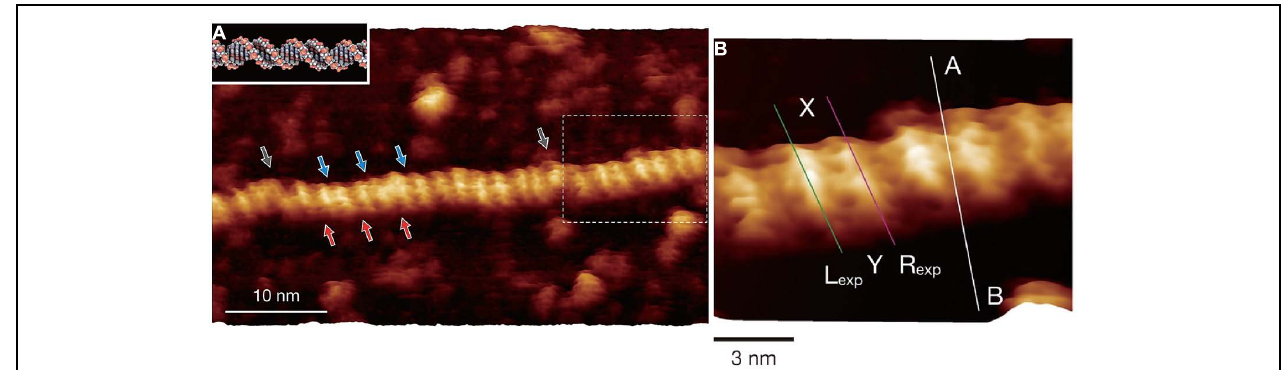
FIGURE 4 | Force modulation AFM topographs of plasmid pUC18 DNA (2686 basepairs) in aqueous solution. The aqueous solution contained Ni 2 + to stabilize the interaction between DNA and mica. (A) High resolution force modulation AFM topograph of a section of the duplex DNA with major (red arrows) and minor (blue arrows) grooves identified along the B-DNA double-helical structure. The white dotted area